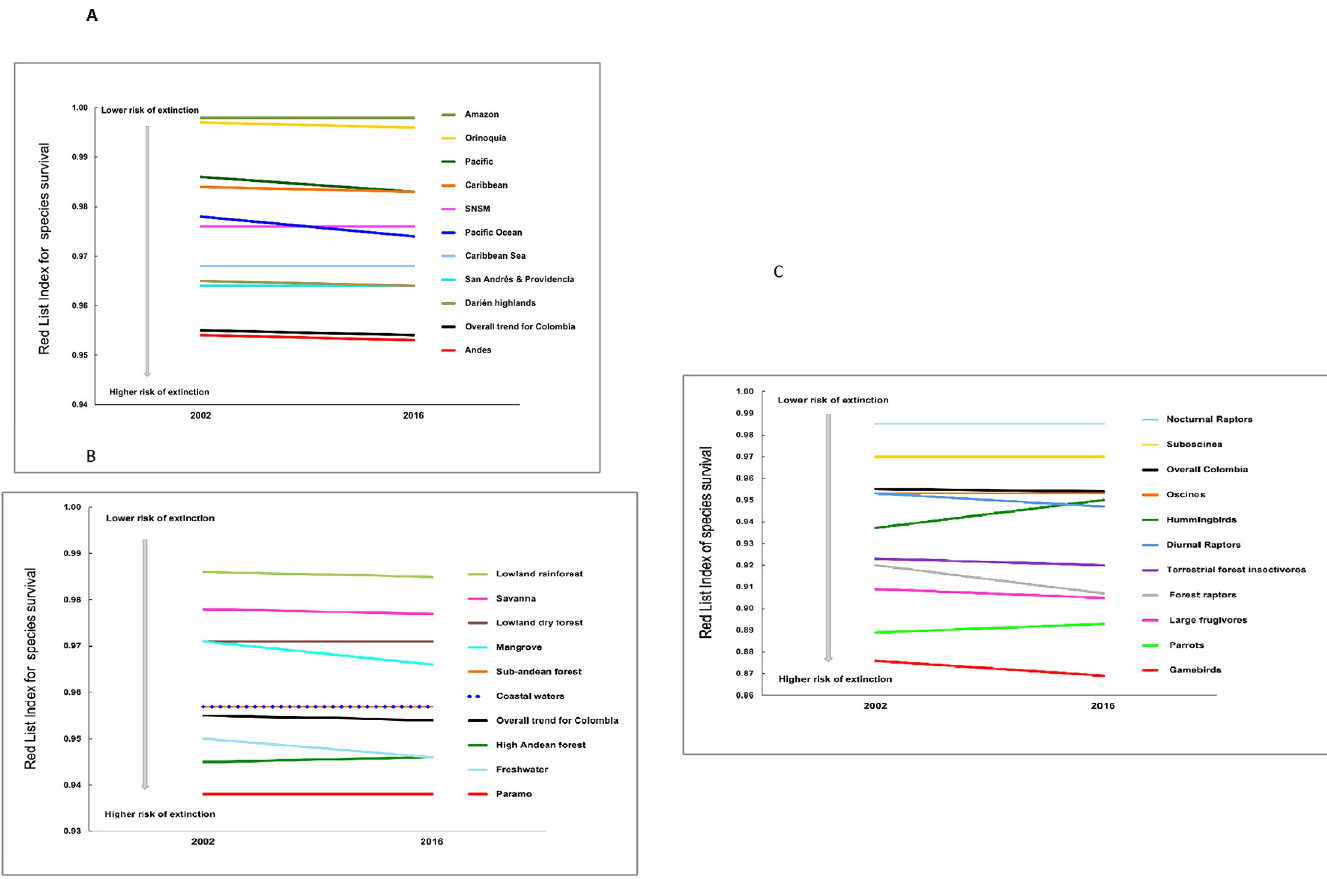
Fig 2. Disaggregated Red List Indices for birds in Colombia in different groups (A) regions, (B) ecosystems, and (C) groups of species of conservation interest. The overall national RLI is shown in black.